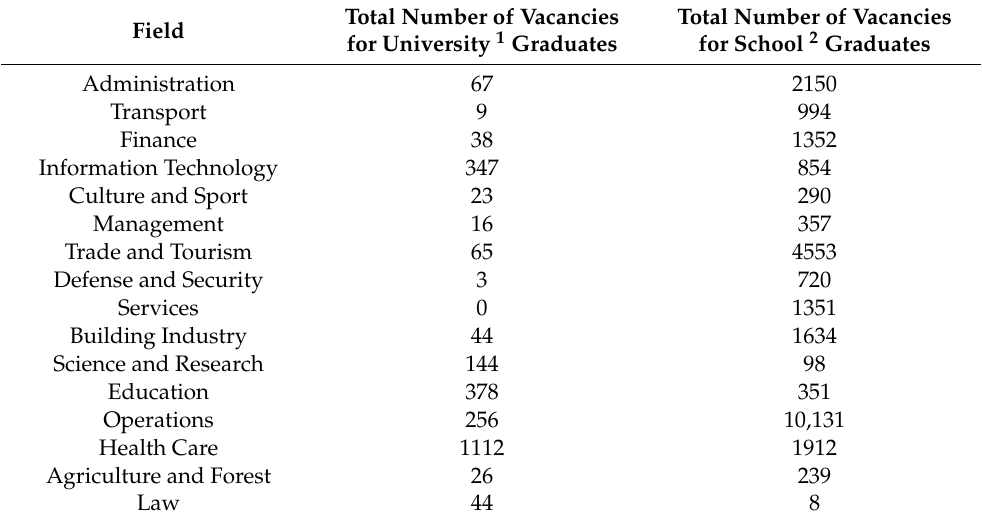
Table 9. The statistics of vacancies for university graduates and high school graduates in the Czech Republic on the date January 18, 2019 [28].